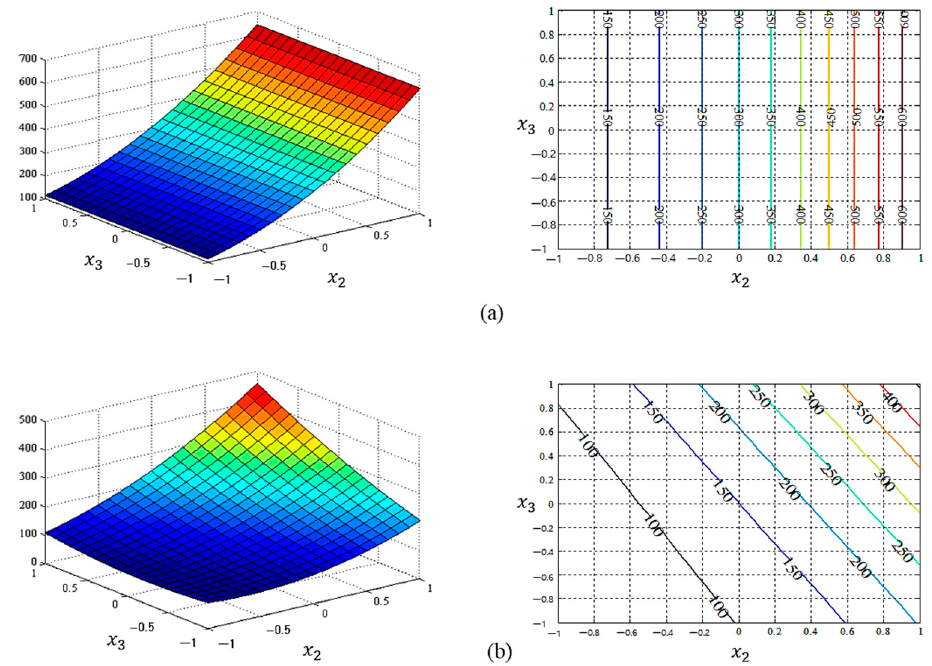
Figure A2. Graphical representation of the estimated mean response functions between x 2 and x 3 : ( a ) the response surface plot and response function of LSM; ( b ) the response surface plot and response function of NN.